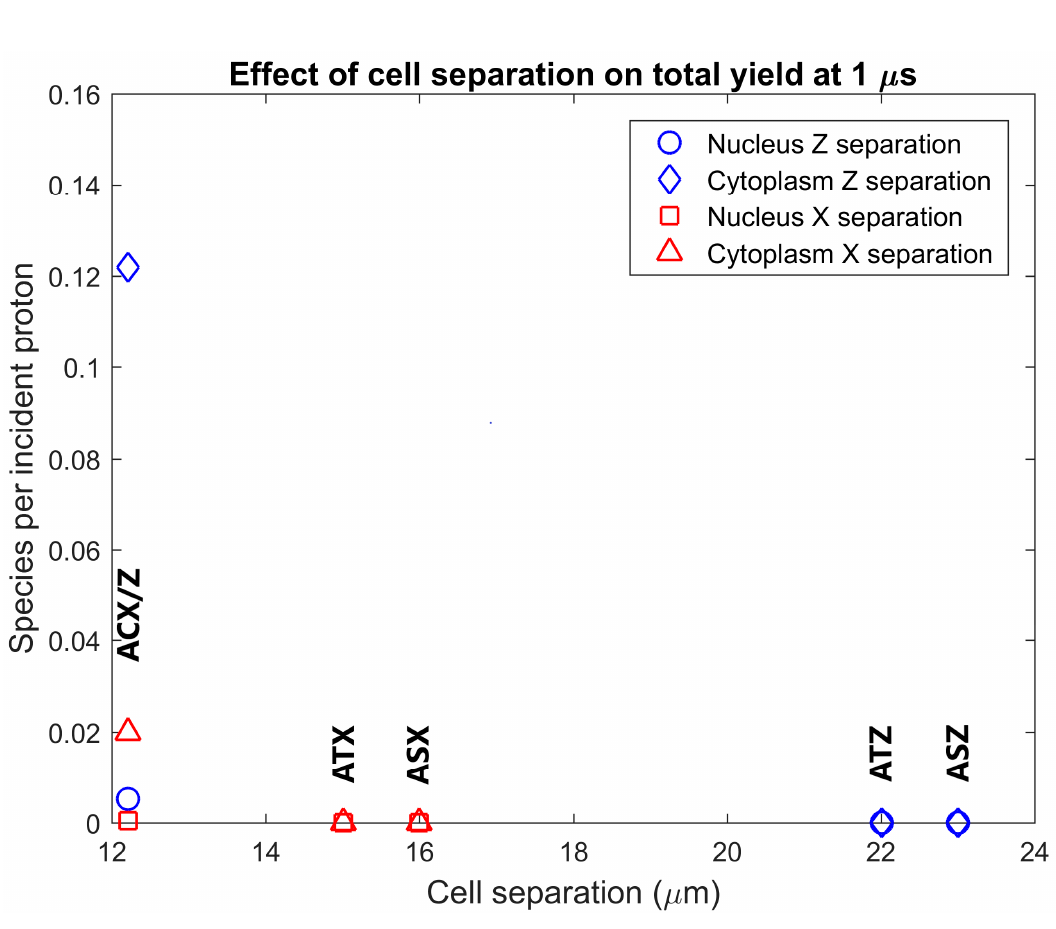
Figure 5. Effect of separation between the centre of the nuclei of the cells on the radiolysis yield at 1 µs in the nucleus and cytoplasm of the adjacent cell from electrons emitted by GNPs within the primary cell. Results are shown for separations parallel to the proton beam (along the Z axis) and perpendicular to the proton beam (along the X axis). The separations along each axis were chosen representing from lowest to highest respectively cells packed together causing a flattening of the cells just beyond the GNP distribution radius, adjacent cells with the membranes in close contact but not compressed together and adjacent cells with a 1 µm gap between the cell membranes.